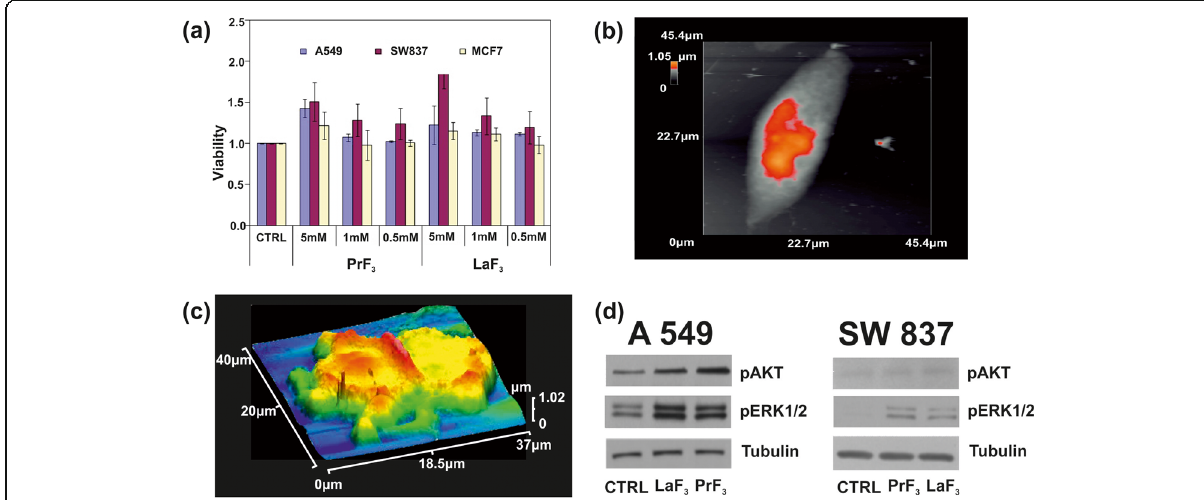
Fig. 9 a WST viability assay histograms of three different cancer cell lines (A549, SW837, MCF7) treated with different concentrations of PrF 3 and LaF 3 NPs in biological media. b AFM image of a single A549 cancer cell. c AFM image of a divided A549 cancer cell in RE-NPs in DMEM+FMS. d Wb phosphorylation analysis of the A549, SW837 cells with AKT and ERK